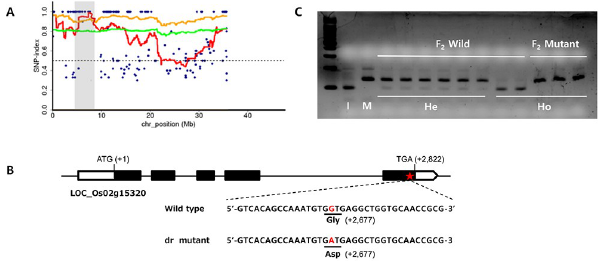
Fig 7. Identification of the dr gene. (A) SNP index plot of chr. 2 for identification of genomic regions harboring the causal mutation of dr gene. Gray shaded area is the region of the casual mutation. Blue dots represent SNP index values at a SNP position. Red line represents the sliding window average of SNP index values of the 4Mb interval with 10kb increments. Green line indicates the sliding window average of 95% confidence interval. Orange line indicates the sliding window average of 99% confidence interval. (B) Schematic diagram of the dr gene. Black rectangles represent exons and the red star represents the mutation site. (C) Co-segregation analysis of F 2 plants using dCAPs markers. I; Ilpum, dr ; dr , He; Heterozygous, Ho; Homozygous.